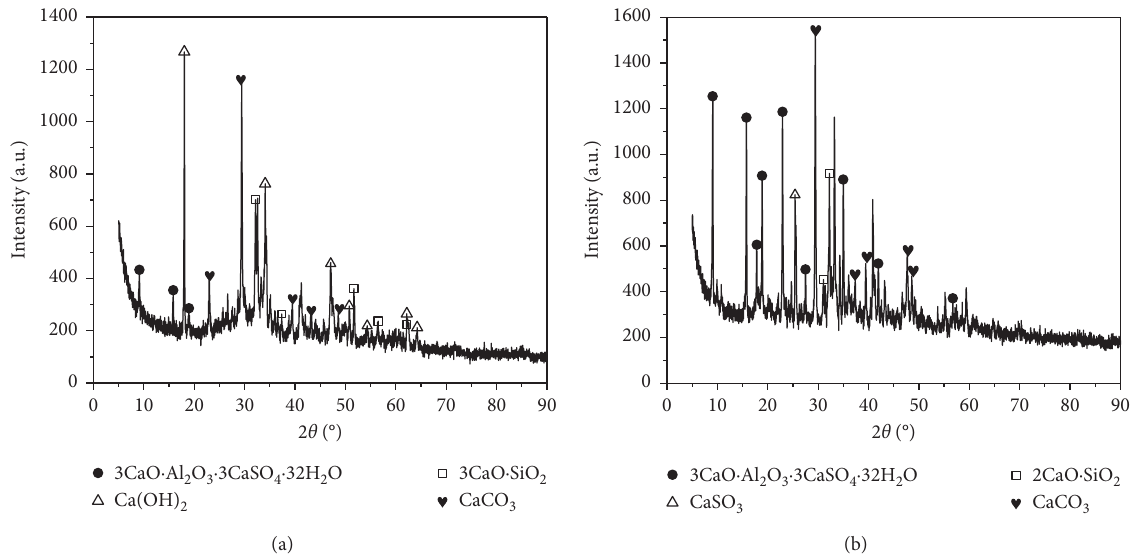
Figure 8: XRD pattern of cured foam filling material when molded for one day. (a) OPC. (b) LASC.